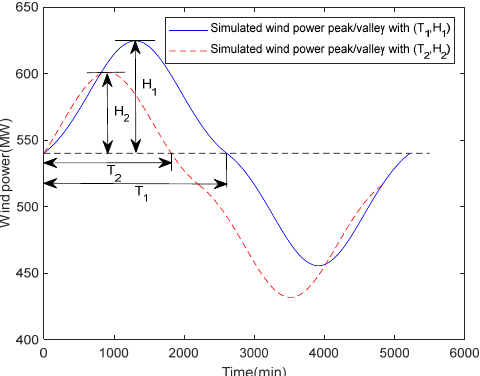
Figure 4. Simulated wind power peak curve using Gaussian distribution.